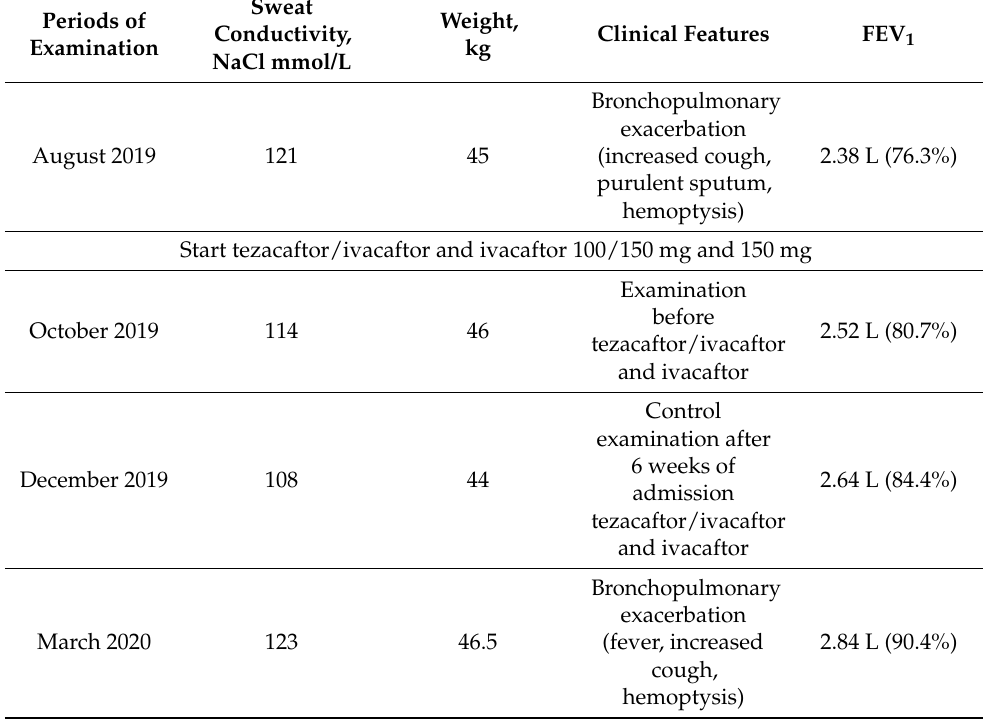
Table 1. Information on the hospitalization of the patient and the course of the disease for